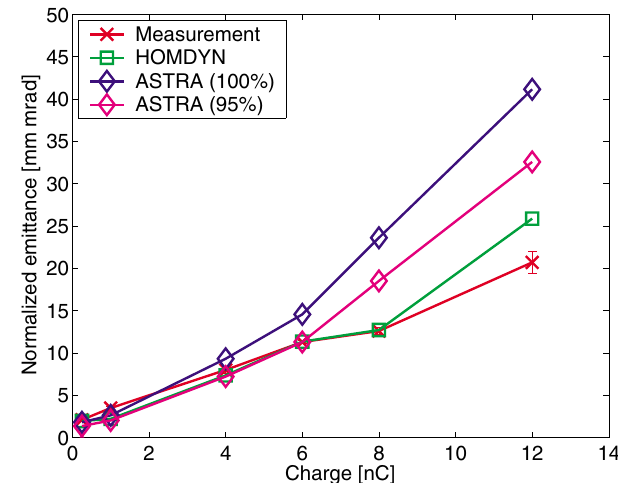
FIG. 2. (Color) Comparison of the measured and simulated minimum normalized vertical emittance at z (cid:3) 3 : 8 m as a func- tion of the charge per